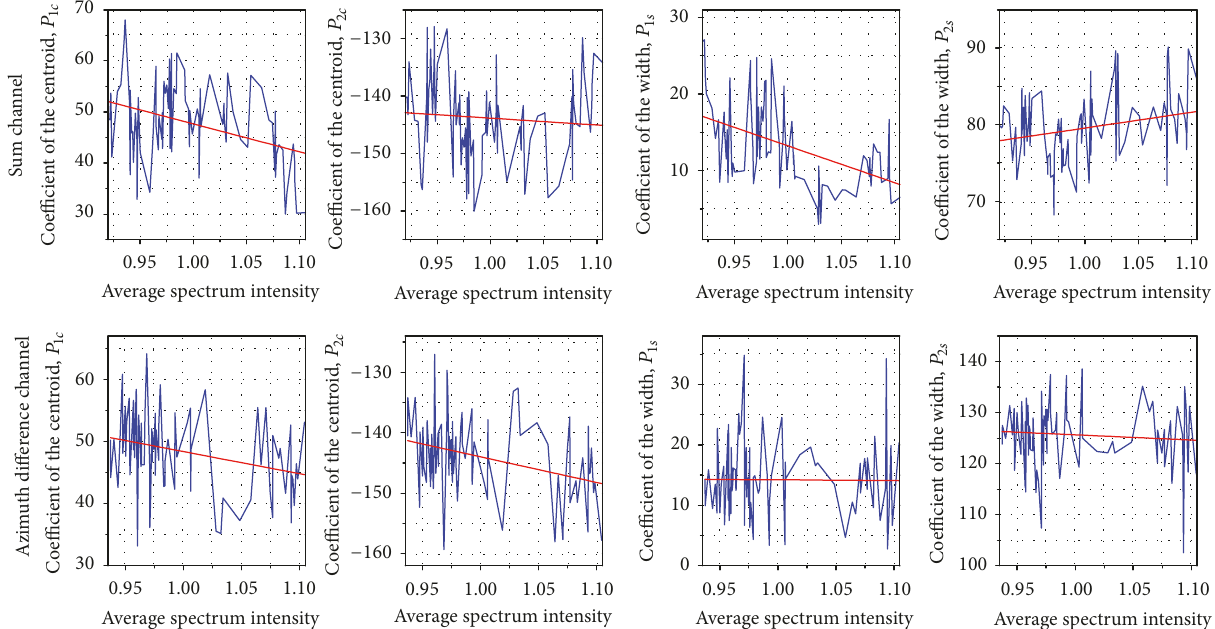
Figure 25: The coefficients of the linear models versus intensity for the sum and azimuth difference channels, with least-mean-square error straight-line fit: blue, data; red, model